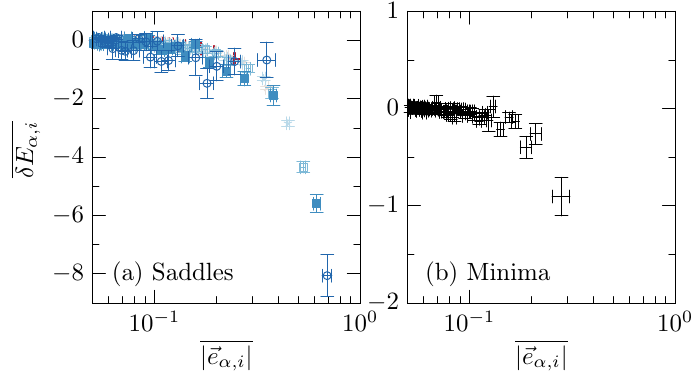
| vs. δ E = 0.32 for (a) saddles and (b) local α , i at T , i